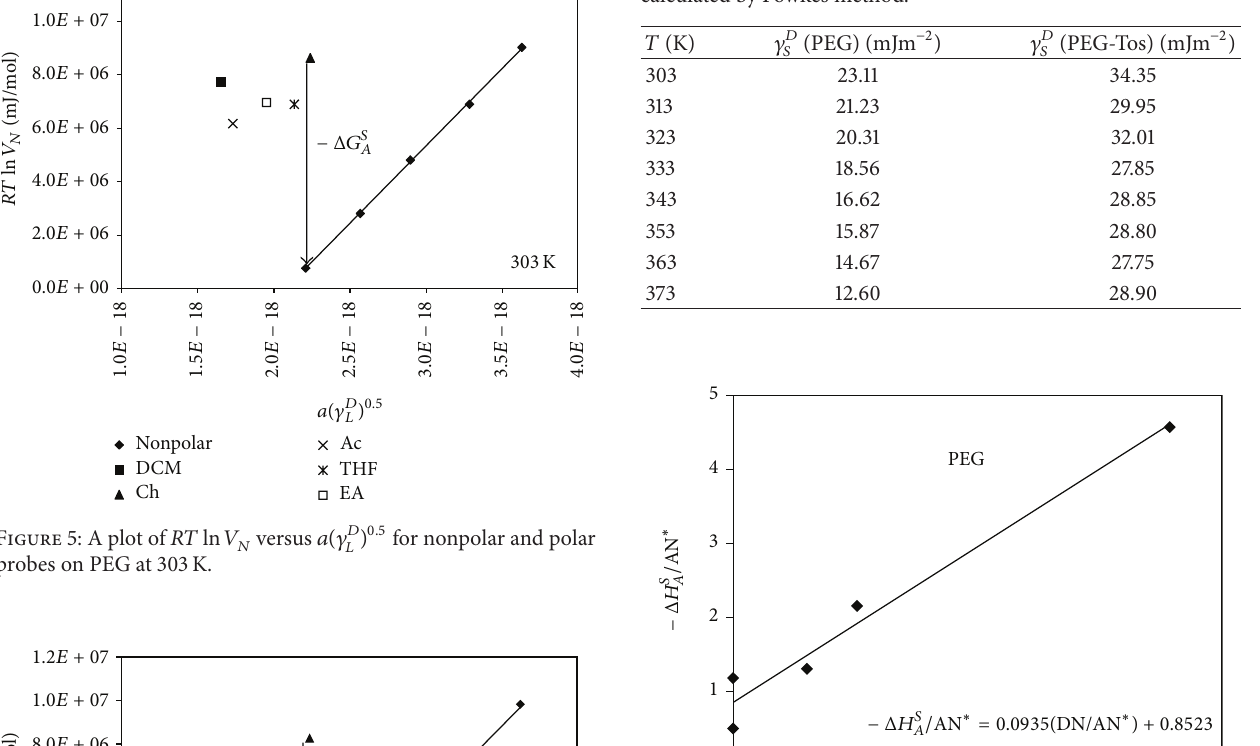
−Δ𝐺 𝑆 𝐴 of PEG and PEG-Tos were calculated using the difference between the calculated value of 𝑅𝑇 ln 𝑉 𝑁 and that which was derived using (3) of the linear fit of the nonpolar reference line. The straight reference line defined the London dispersive interactions, while the polar probes lied above this line, indicating that acid-base interactions were